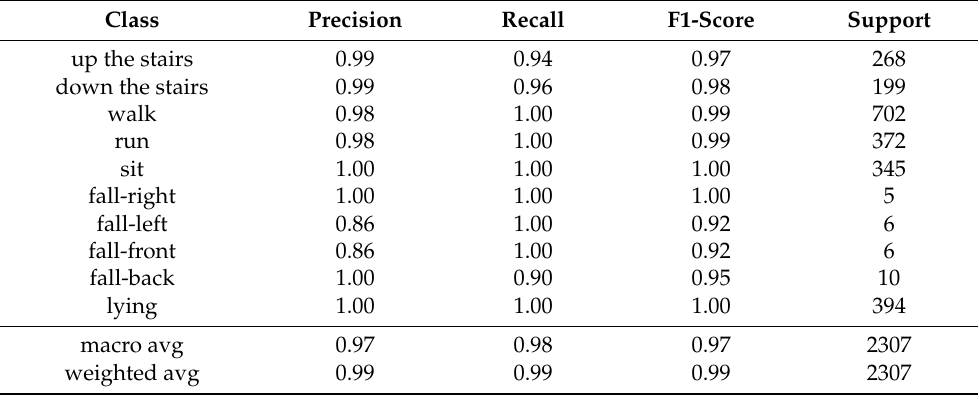
Table 3. Classification report using feature learning-based approach.